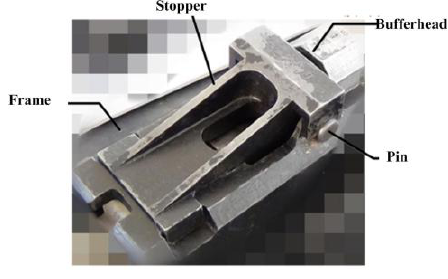
Figure 19. The use conditions of stopper.